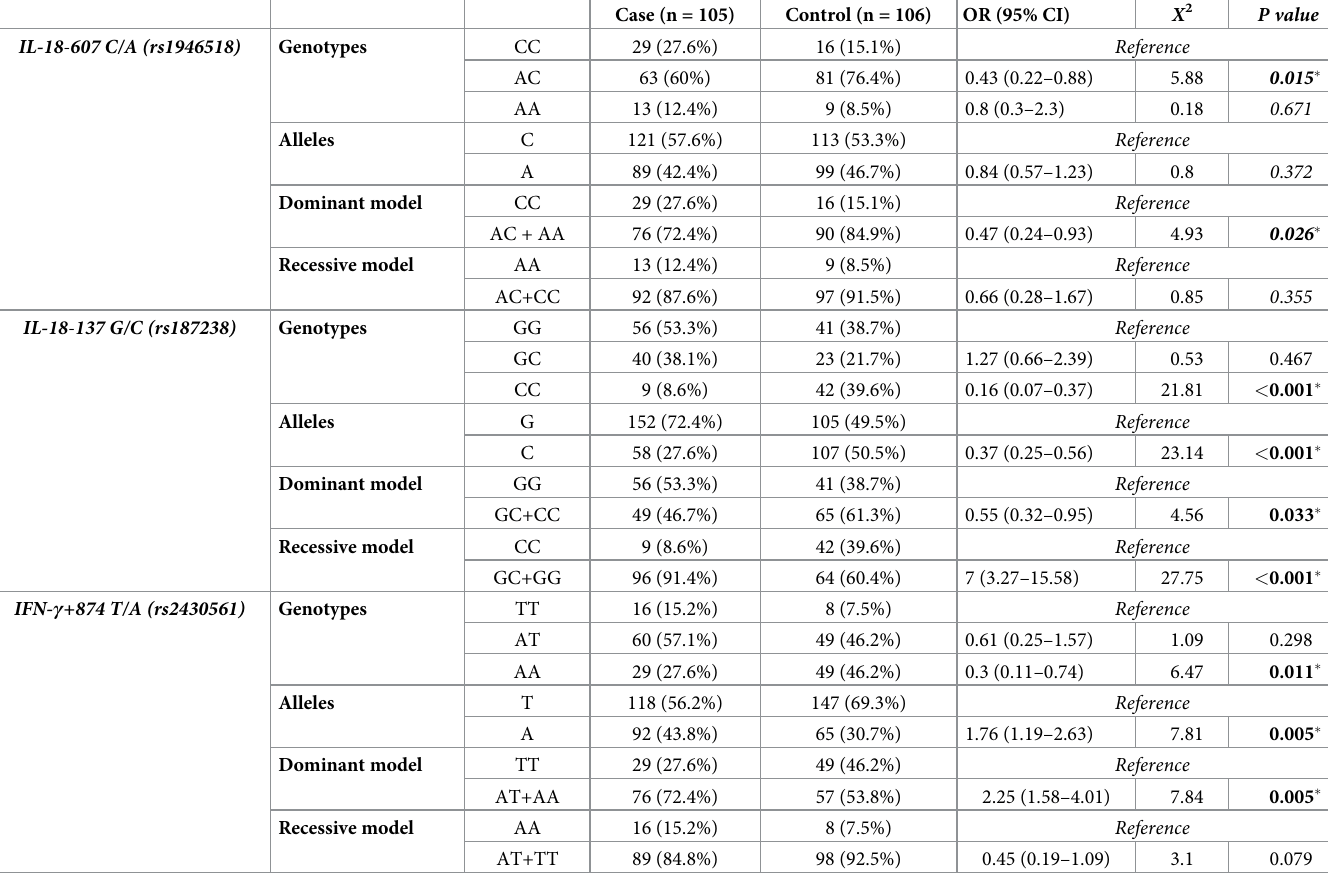
Table 3. Genotypic & allelic frequencies of the studied cohort (cases vs.